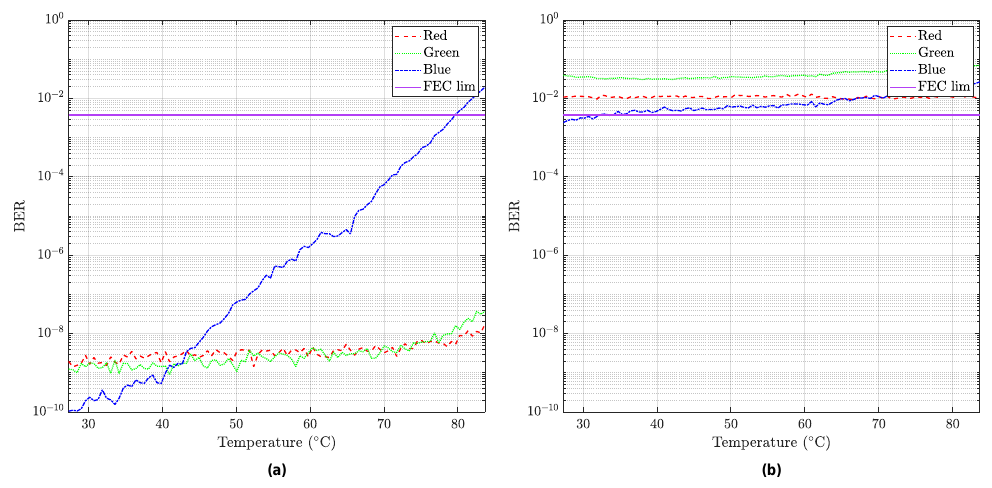
Figure 13. BER at different temperatures, compensating the channel using the CSI corresponding to 27°C and with a medium SNR value (20 dB). ( a ) Sony IMX249 and ( b ) Foveon X3. Dashed line, dotted line, and dash-dot line correspond to red, green, and blue, respectively.